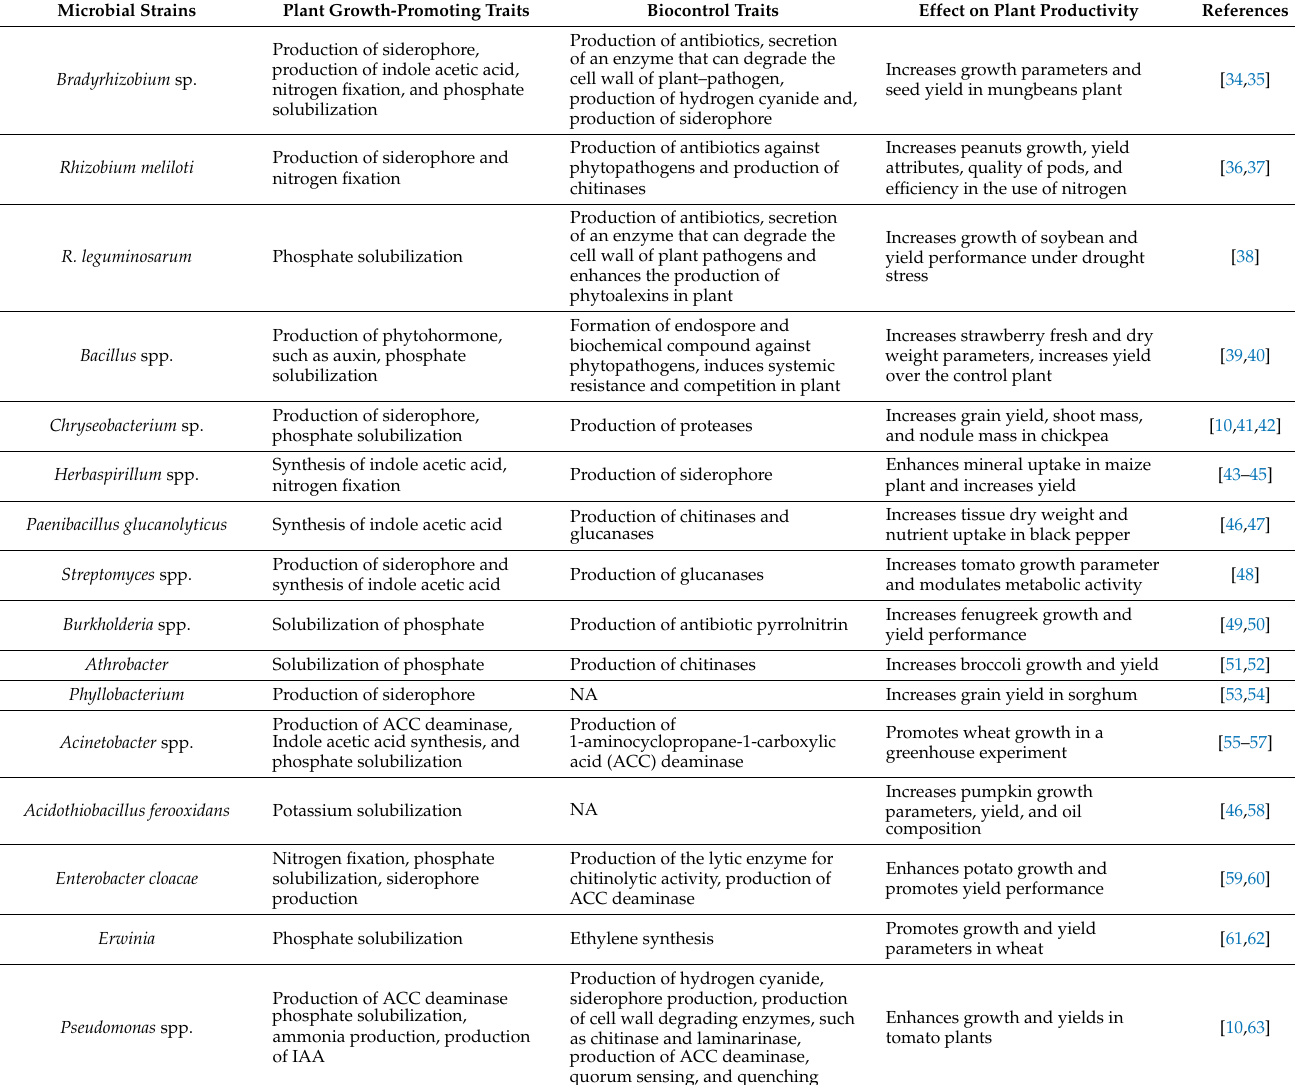
Table 1. Rhizobacteria used in the production of biofertilizer, biocontrol traits, and their effect on plant productivity Microbial